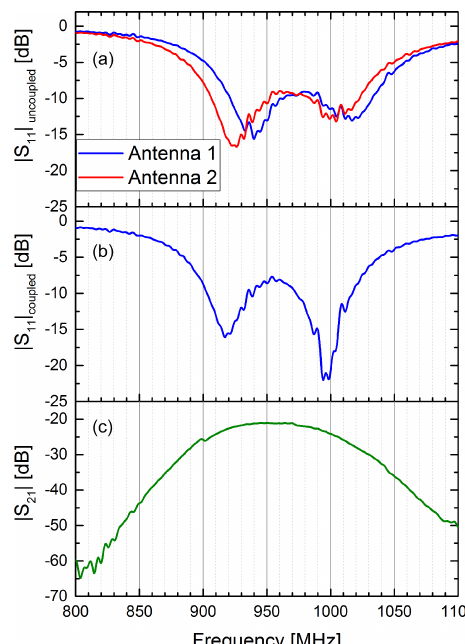
Figure 2. Coupling of two antennae in free space. The upper di- agram (a) shows the S 11 parameter of the two antennae without the other antenna in its vicinity. In this case both antennae are un- coupled. Clearly visible are the two resonance frequencies for the antenna’s two transmission bands between 900 and 1050MHz. The middle diagram (b) shows the S 11 parameter of the first antenna, when the second antenna is in its close vicinity. In this case, both antennae are closely coupled. It can be seen that the resonance fre- quencies of the first antenna shifts to slightly lower frequencies compared to the uncoupled case. Also, the higher frequency res- onance becomes much more prominent by shifting roughly 10dB down. The lower diagram (c) shows the S 21 parameter of the cou- pled antenna pair.